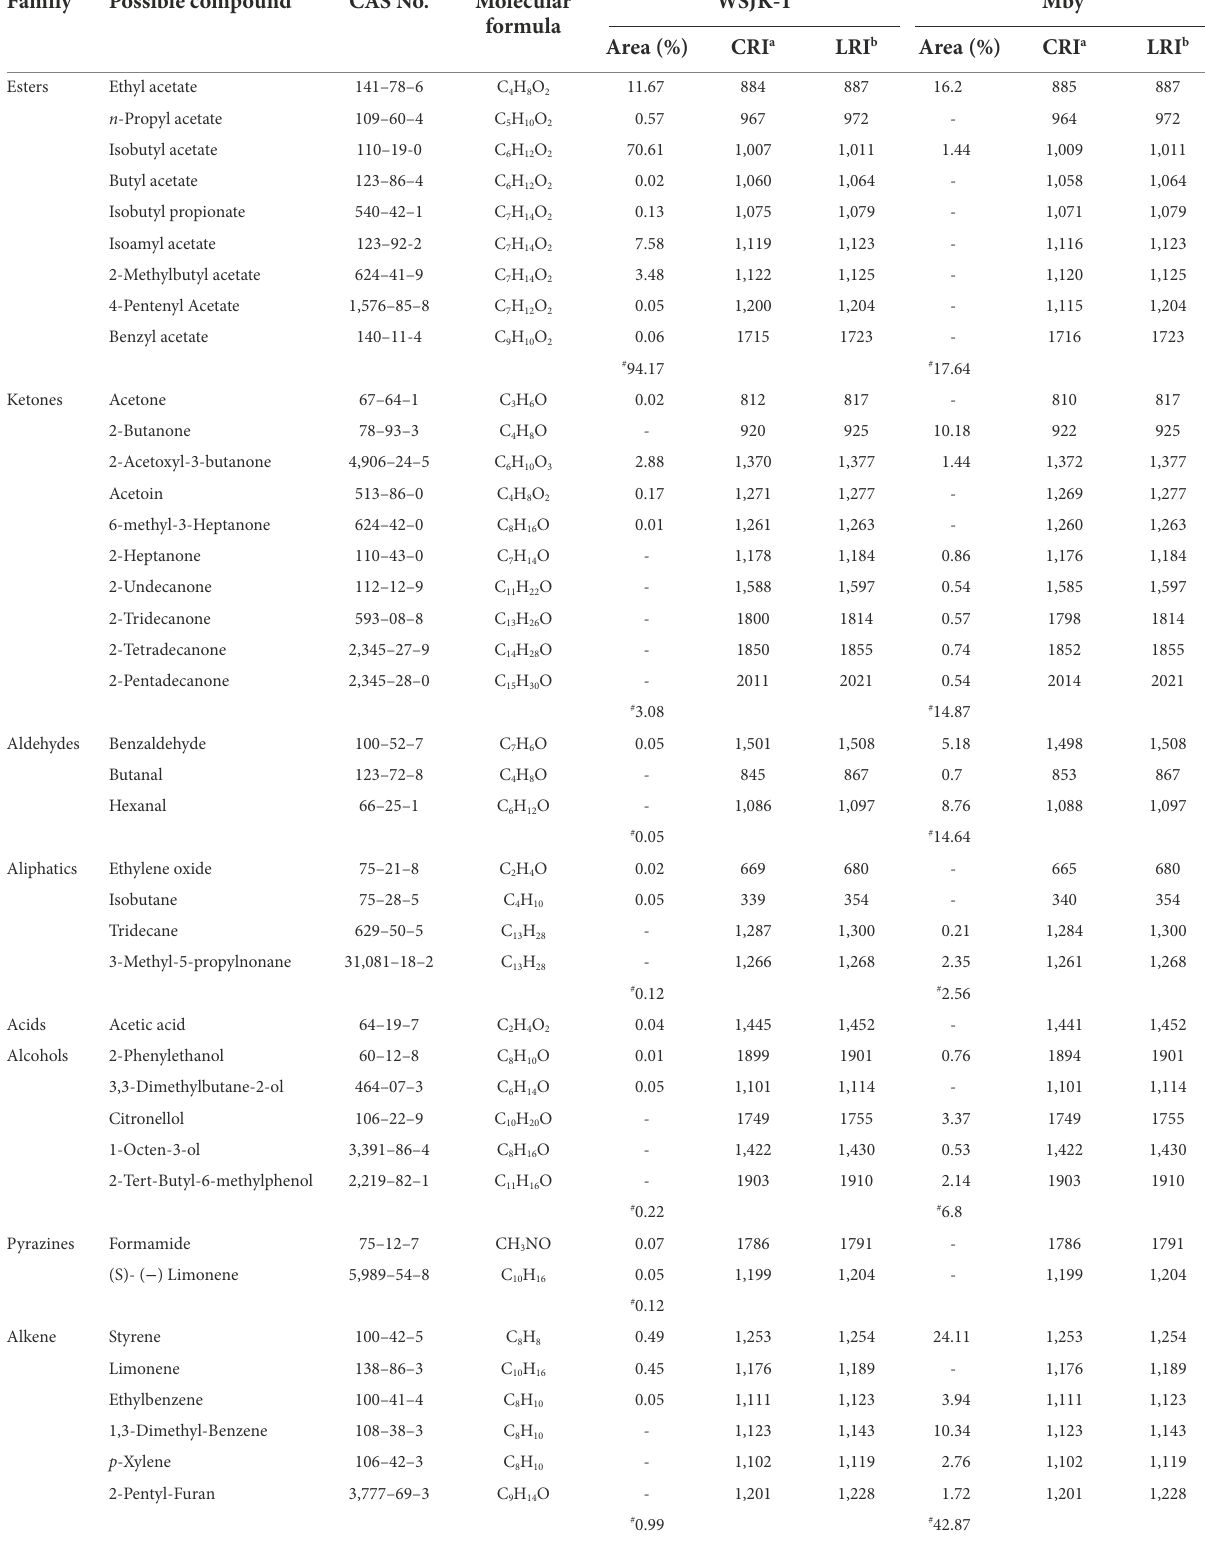
TABLE 3 VOCs from C. fimbriata strains WSJK-1 and Mby produced on 7-day-old PDA culture detected by SPME-GC–MS analysis*.